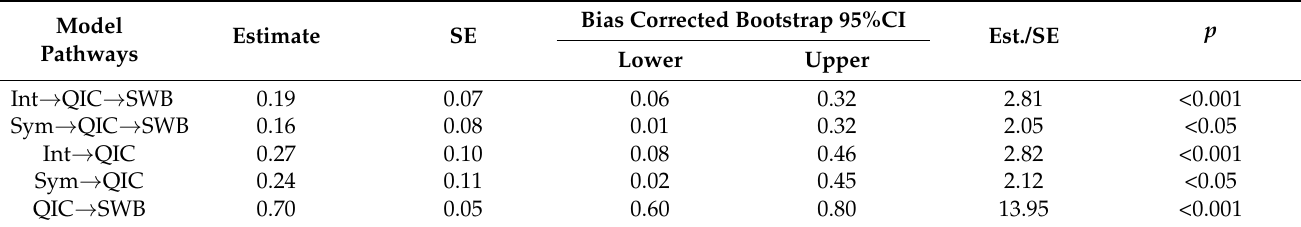
Table 3. Standardized effects and 95% confidence